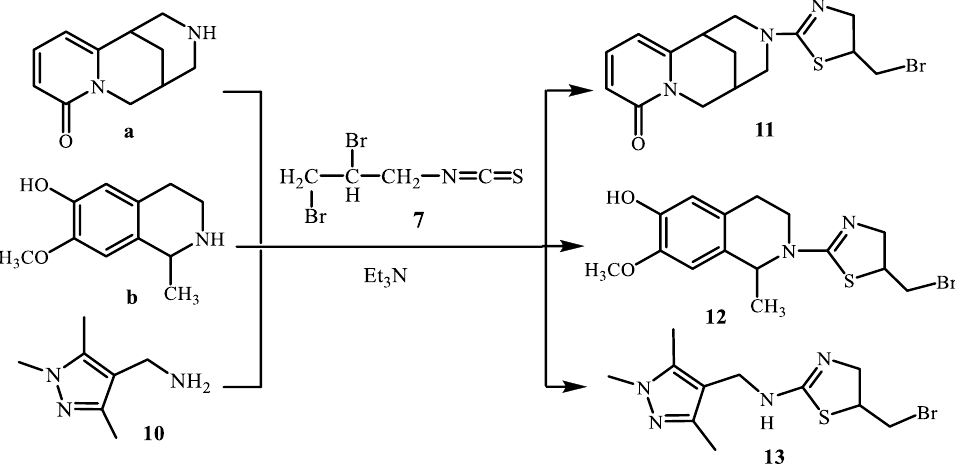
Scheme 5. Interaction reaction of alkaloids ( a ), ( b ), amine 10 with 2,3-dibromopropylisothiocyanate 7.